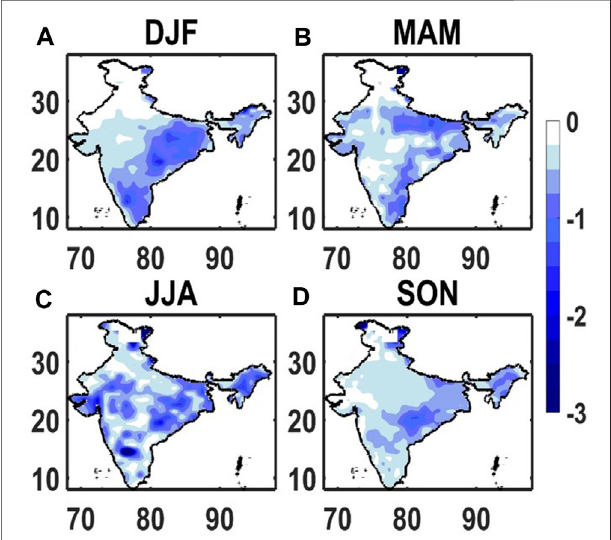
FIGURE 8 | Variation of ARF (W ° m − 2 ) difference (TOA) calculated from derived ARFE map over Indian region for (A) Winter (DJF), (B) Pre-monsoon (MAM), (C) Monsoon (JJA), and (D) Post-monsoon (SON) from CERES SW- Flux data.